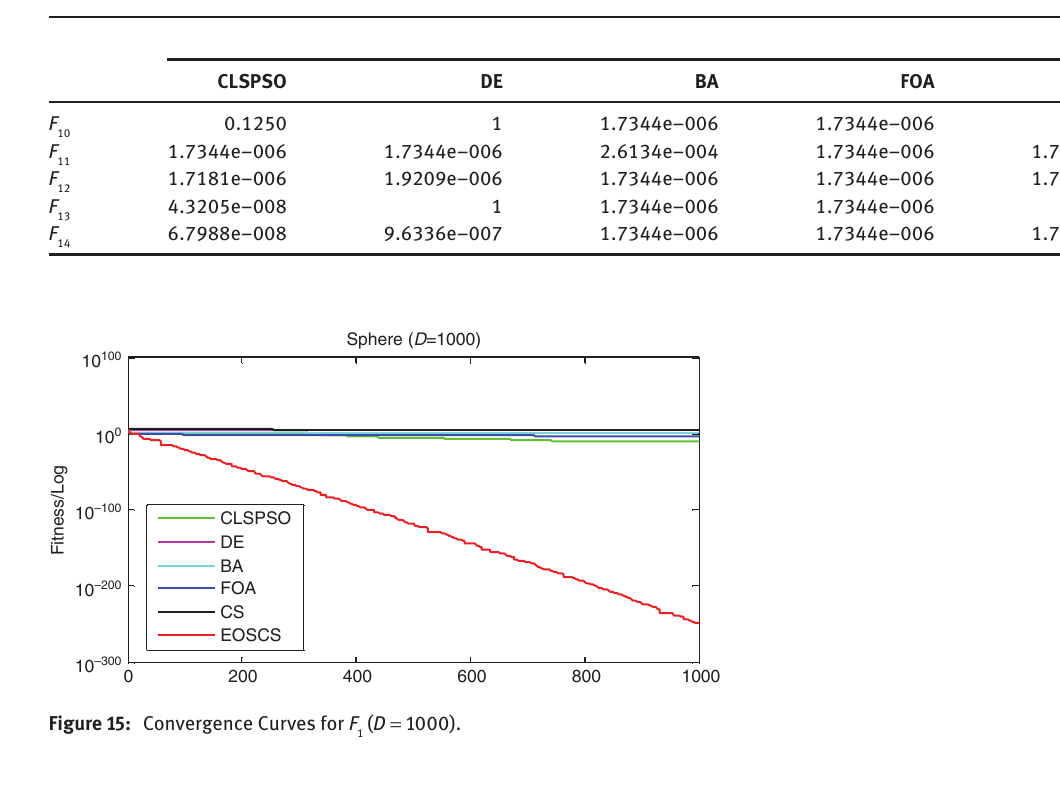
Table 10: p -Values Produced by Wilcoxon’s Test Comparing EOSCS versus CLSPSO, EOSCS versus DE, EOSCS versus BA, EOSCS versus FOA, and EOSCS versus CS Over The “Average Best-So-Far” Values From Table 2.